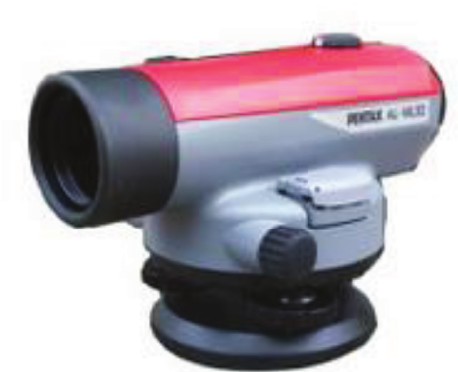
Figure 5: The AL-ML32 high-precision leveling instrument.